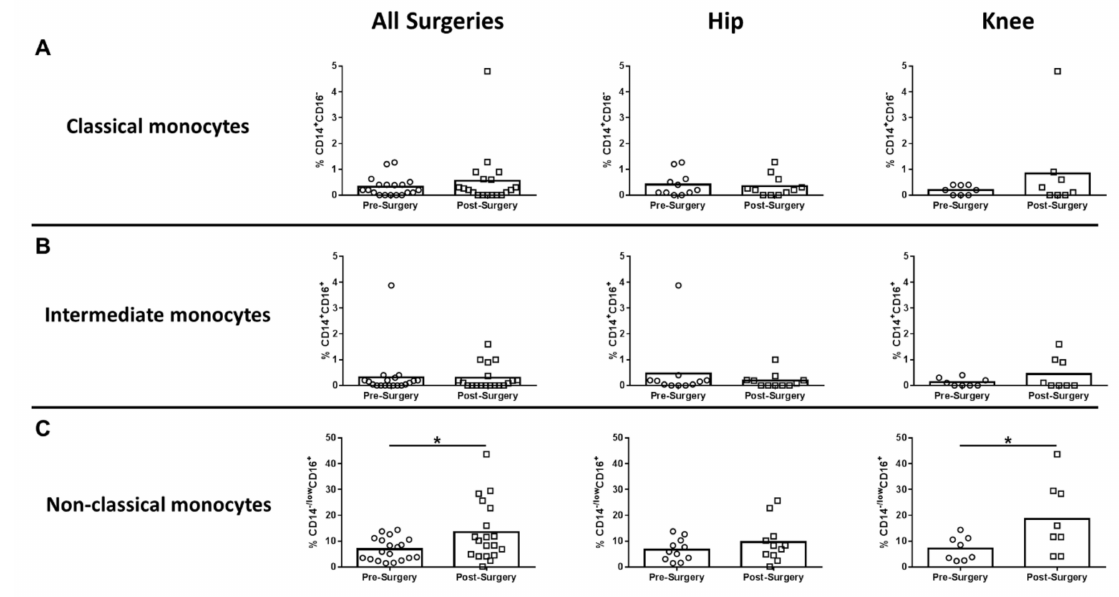
Figure 2. Non-classical monocytes are increased systemically following hip / knee arthroplasty. Blood samples collected from patients pre- and post-surgery for THA ( n = 11) and TKA ( n = 8) were analyzed by flow cytometry. Results were calculated after gating on live CD45 + cells and removing granulocyte and T cell populations from the analysis. Quantification of ( A ) CD14 + CD16 - classical monocytes, ( B ) CD14 + CD16 + intermediate monocytes, and ( C ) CD14 low CD16 + non-classical monocytes is presented (* p < 0.05; unpaired two-tailed Student’s t